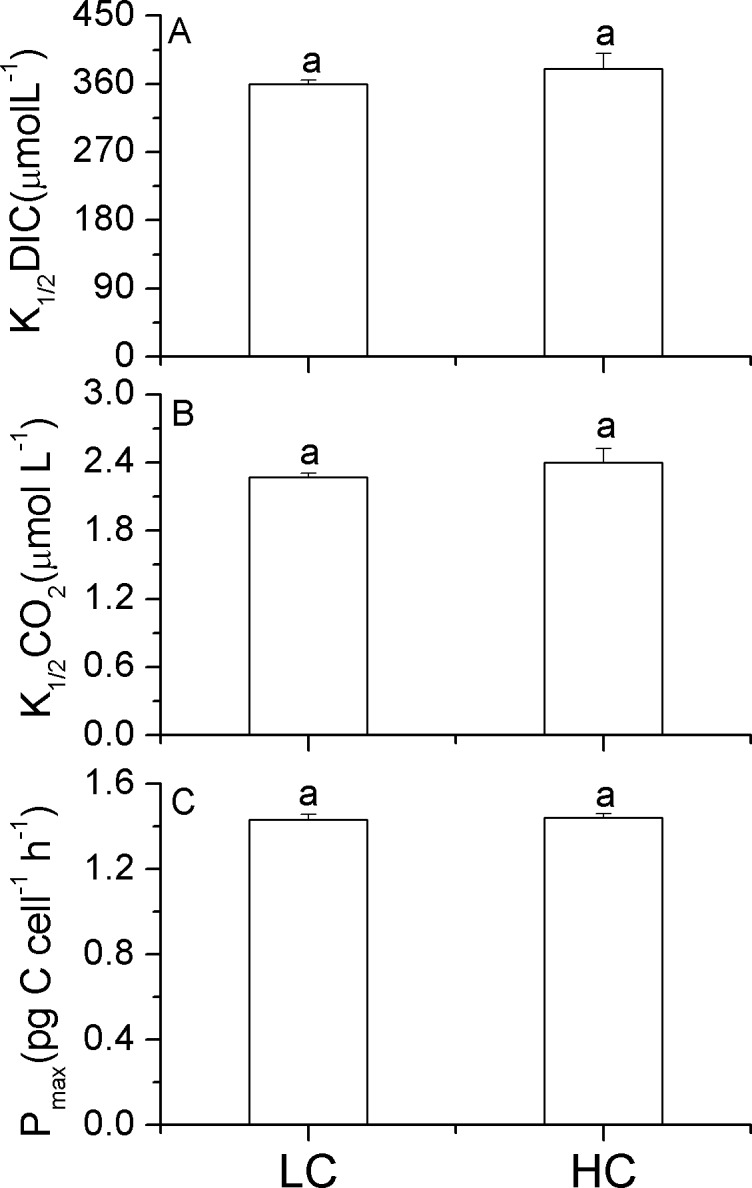
Half-saturation constants (K1/2) for DIC (A) and CO2 (B) and the maximal photosynthetic rate (C) of P. tricornutum. The half-saturation constants for dissolved inorganic carbon (A: K1/2 DIC; μmol L-1) or CO2 (B: K1/2 CO2; μmol L-1) concentrations and the maximal photosynthetic rate (C: Pmax; pg C cell-1 h-1) of P. tricornutum cells grown at ambient (390 μatm; LC) and elevated CO2 (1000 μatm; HC) levels. Data are the means ± SD, n = 3 (triplicate cultures). Different letters above the histogram bars indicate significant differences (p<0.05) between different treatments.